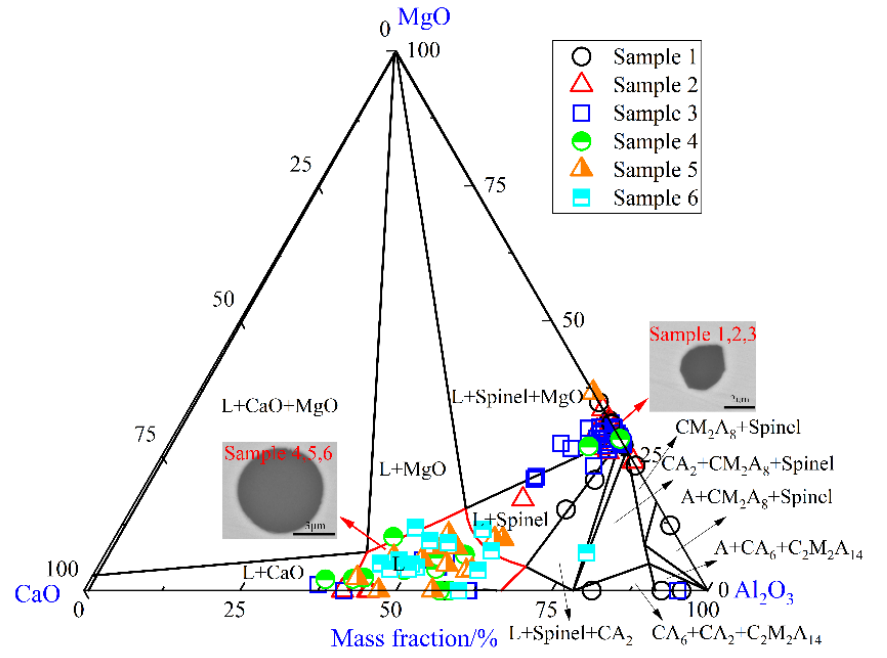
Figure 4. Composition distributions (mass fraction) of inclusions in CaO-MgO-Al 2 O 3 phase diagrams. (L: Liquid Oxide; CA 2 : CaO-2Al 2 O 3 ; CM 2 A 8 : CaO-2MgO-8Al 2 O 3 ; CM 2 A 14 : CaO-2MgO-14Al 2 O 3 ; CA 6 : CaO-6Al 2 O 3 ; Spinel:MgO-Al 2 O 3 ).